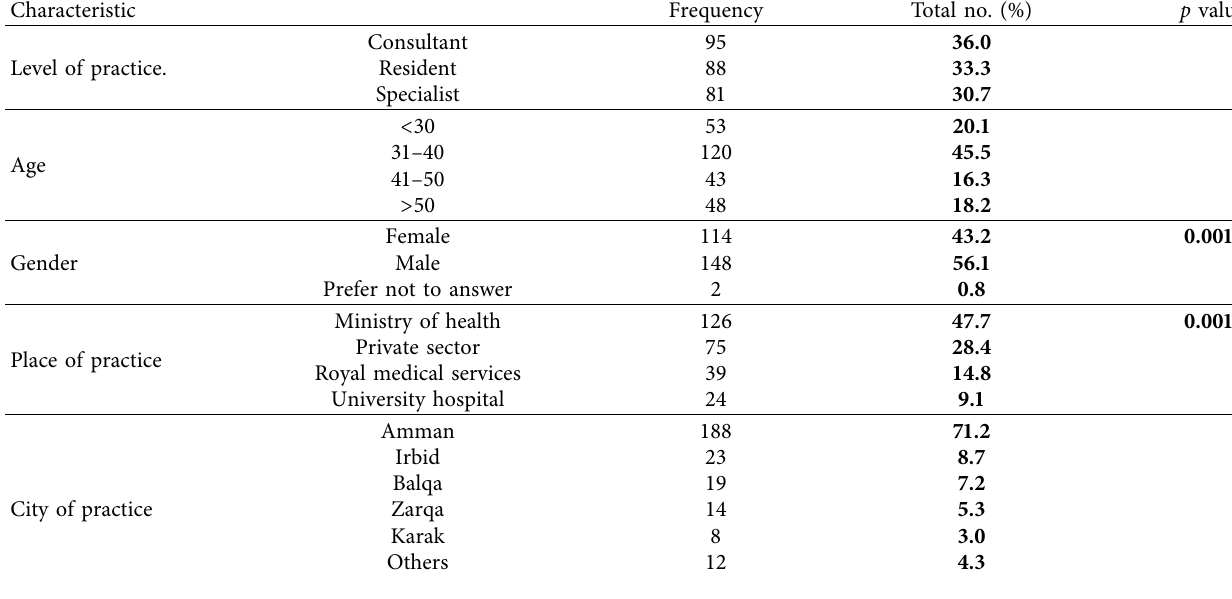
Table 1: Demographics and characteristics of responders.